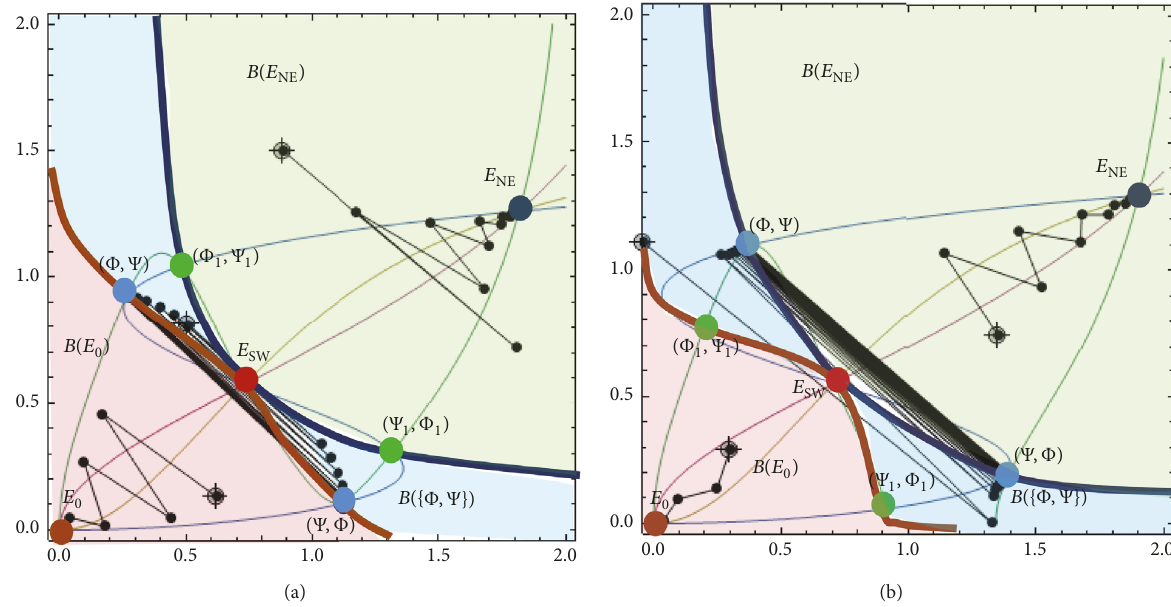
Figure 1: (a) Visual illustration of Theorem 34, case (d). (b) Visual illustration of Theorem 34, case (f).